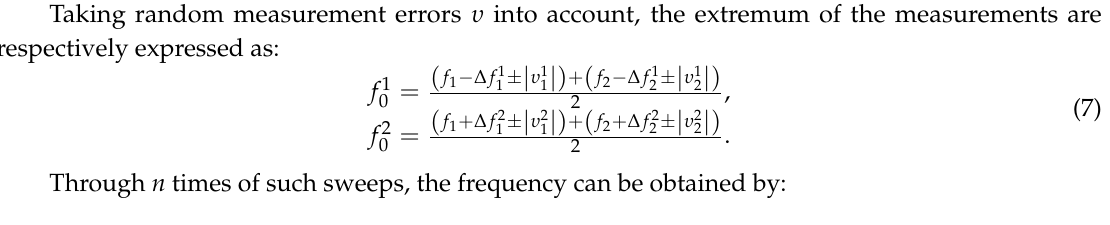
Figure 3. Influence of frequency drift during reciprocating sweeping.